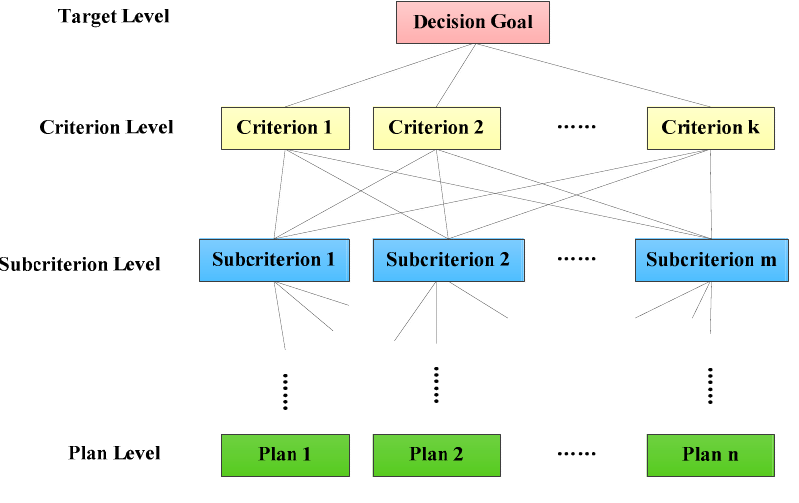
Figure 4. Hierarchical structure.